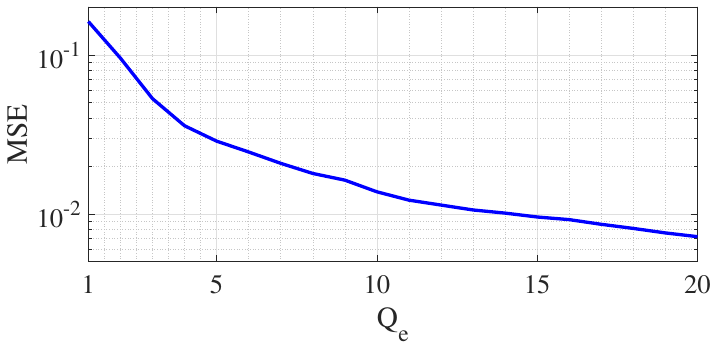
Figure 3. MSE for different lengths of acquisition phase